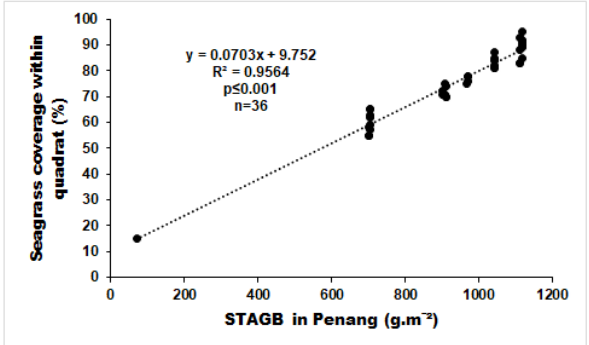
Figure 3. Correlation between STAGB acquired from in-situ measurement with the seagrass proportion of seagrass coverage in Penang.